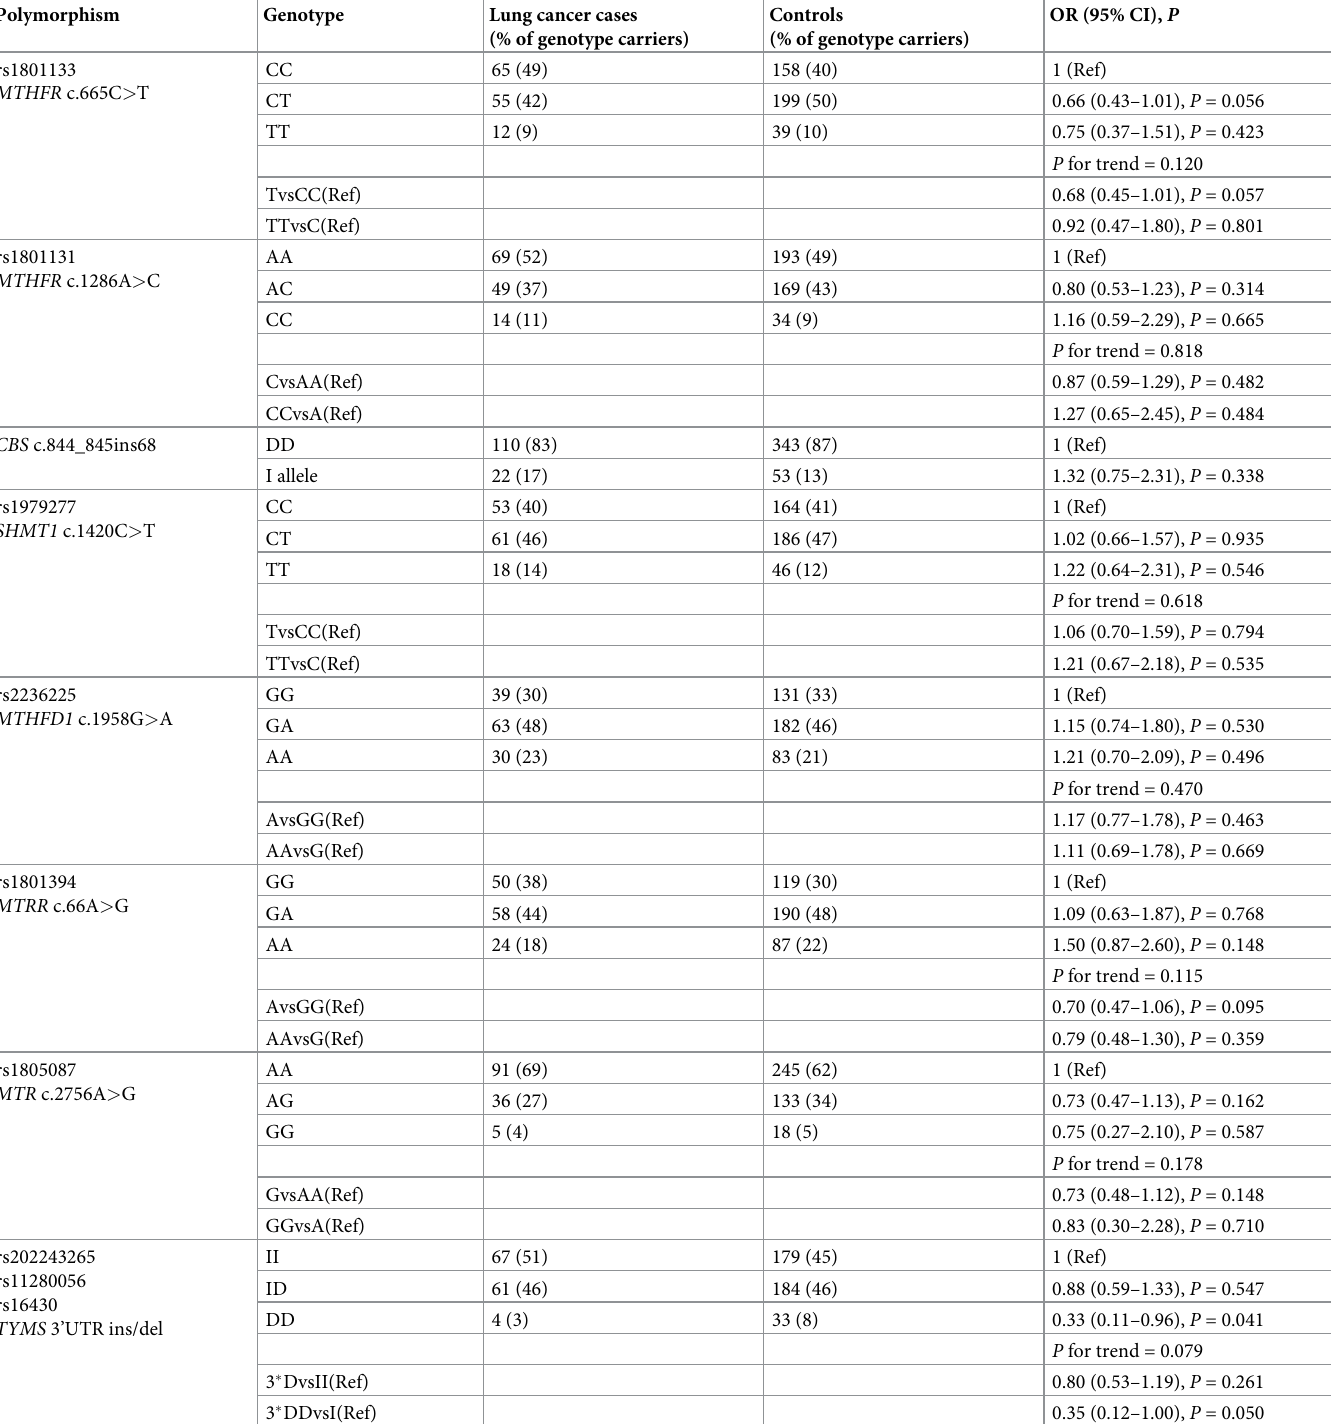
Table 3. Odds ratios of lung cancer occurrence in relation to genotypes in the C1 metabolism genes, in study population from northern